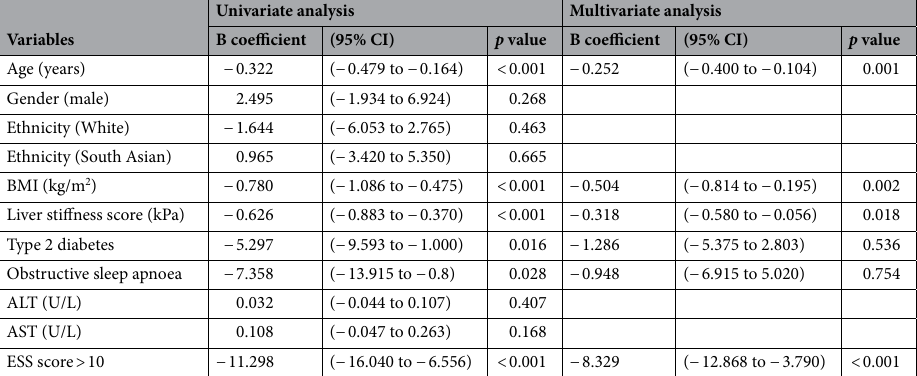
Table 3. Factors Associated with Physical Component Summary (PCS) of SF-36 in all People with NAFLD by Univariate and Multivariate Linear Regression (n = 177). ALT alanine aminotransferase, AST aspartate aminotransferase, BMI body mass index, ESS Epworth Sleepiness